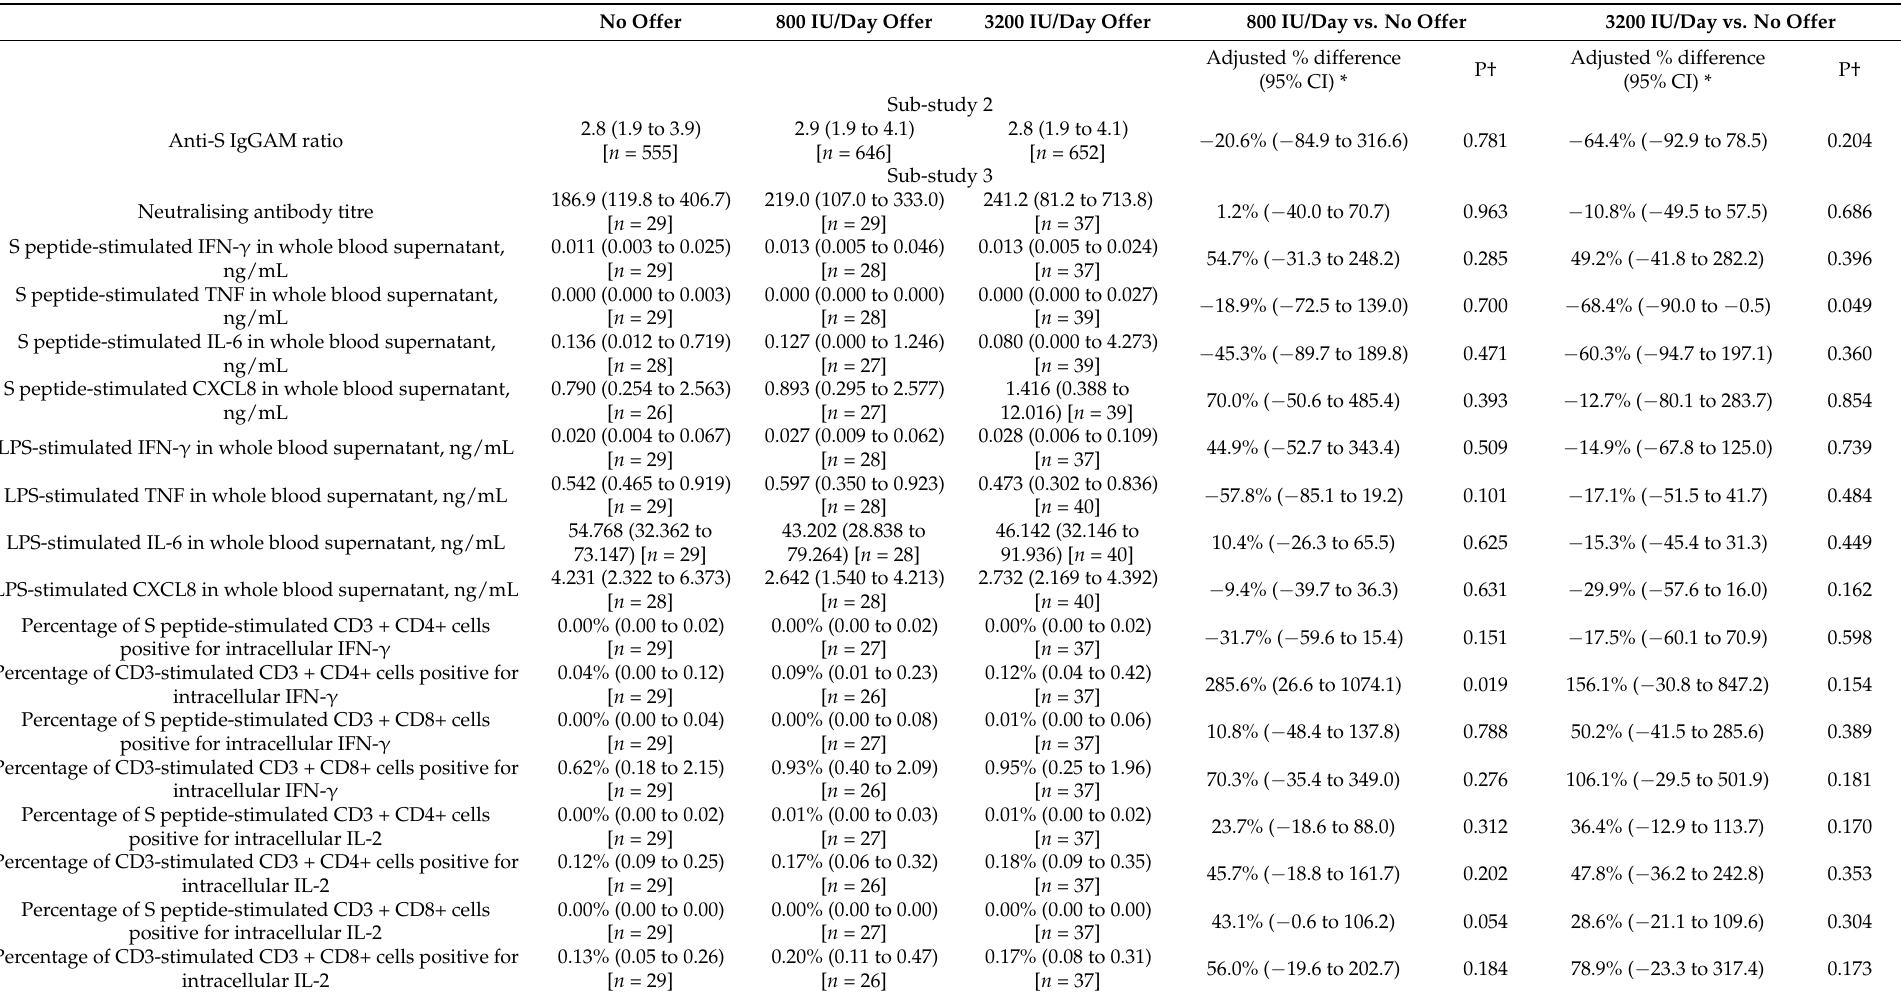
Table 2. Immunological outcomes by